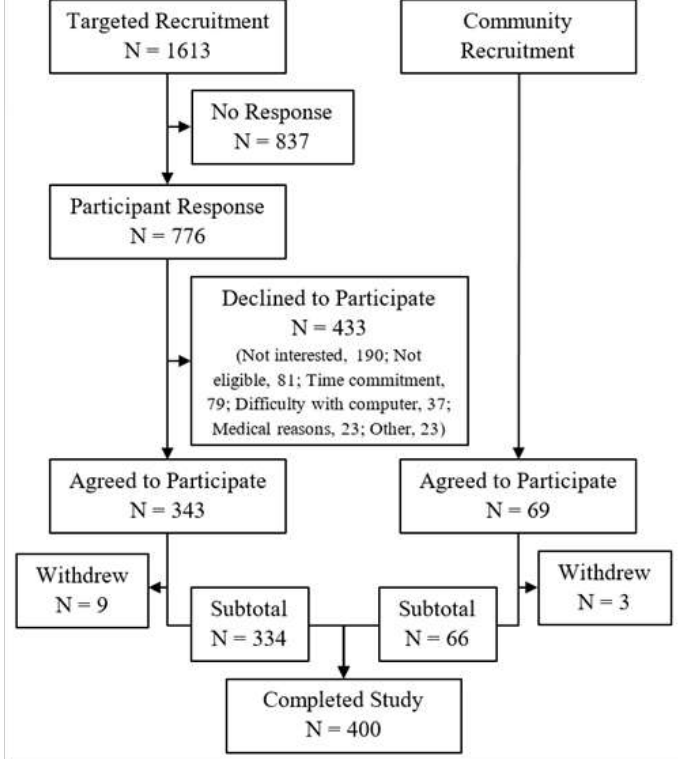
Figure 3. Flow chart of study recruitment. Recruitment for the MEE Study used two primary methods: personalized mailings to members of a breast cancer screening cohort (“Targeted Recruitment”) and general announcements in the community (“Community Recruitment”).